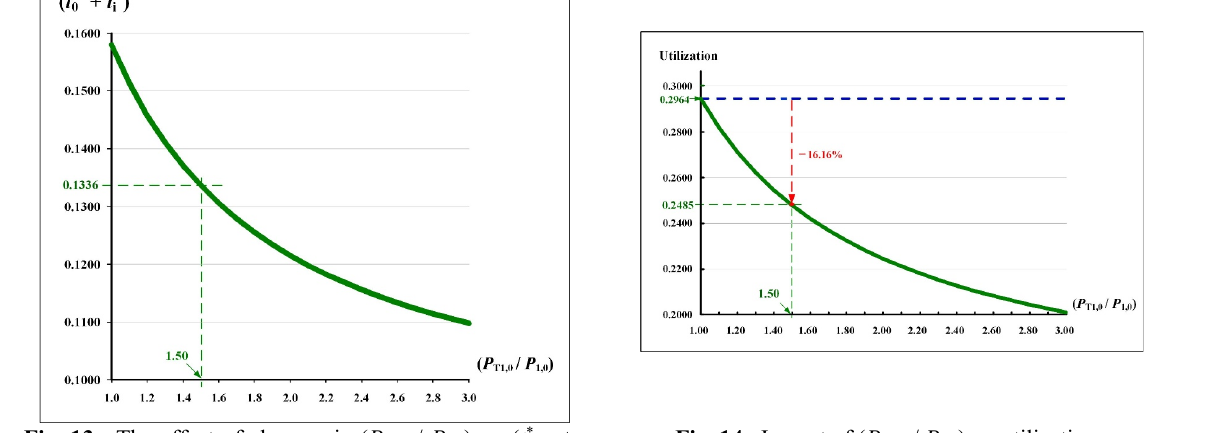
Fig. 13. The effect of changes in ( P T1,0 / P 1,0 ) on ( t * 1,0 + t * 2,0 ).